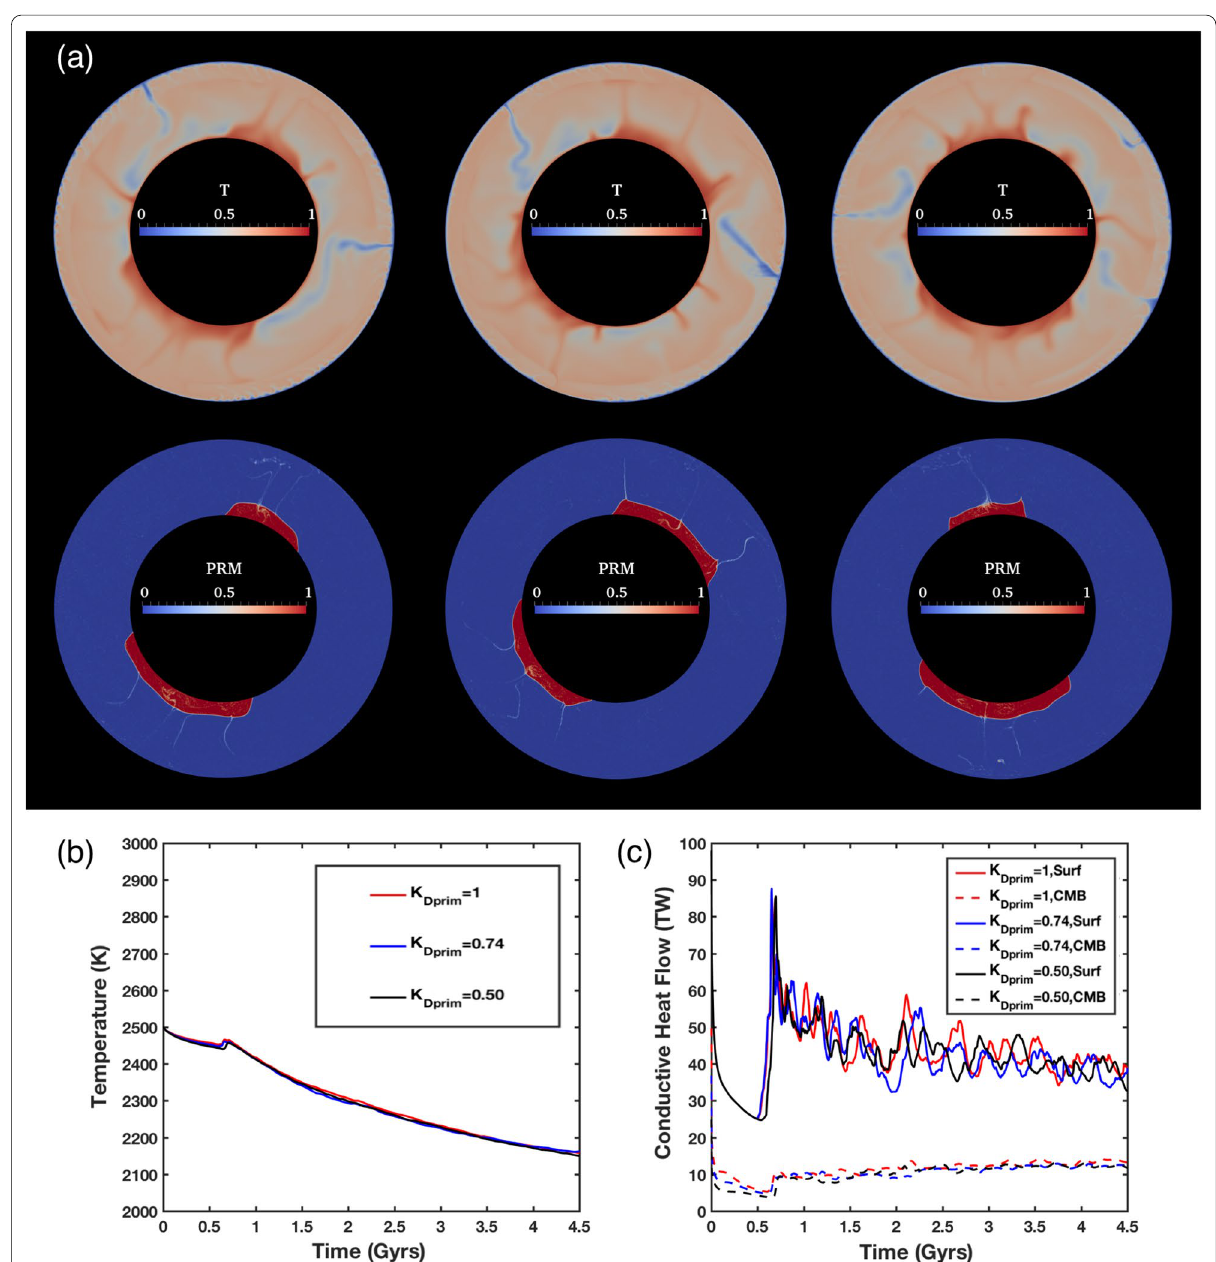
Fig. 1 H Dprim 1, a snapshots of non‑dimensional superadiabatic temperature (top) and composition (bottom) fields at t = right K Dprim varies from 1, 0.74, 0.5. b Averaged mantle temperatures as a function of time. c Surface and bottom heat flows as a function of